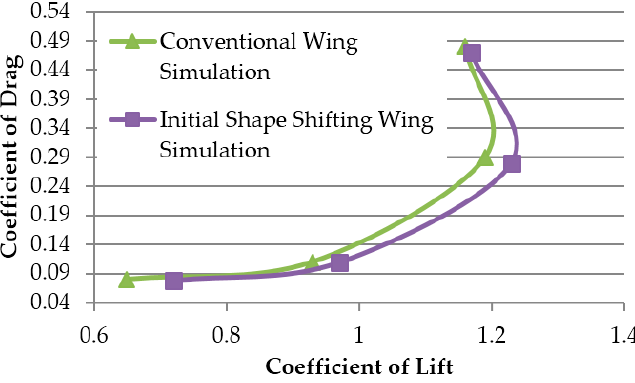
Figure 17. A graph showing Coefficient of drag versus coefficient of lift for the initial morphing and conventional wing.